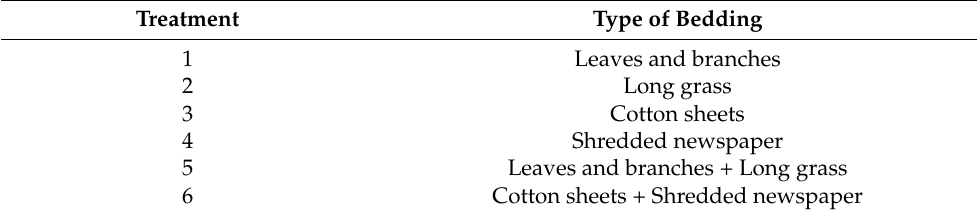
Table 2. Types of bedding materials used during the